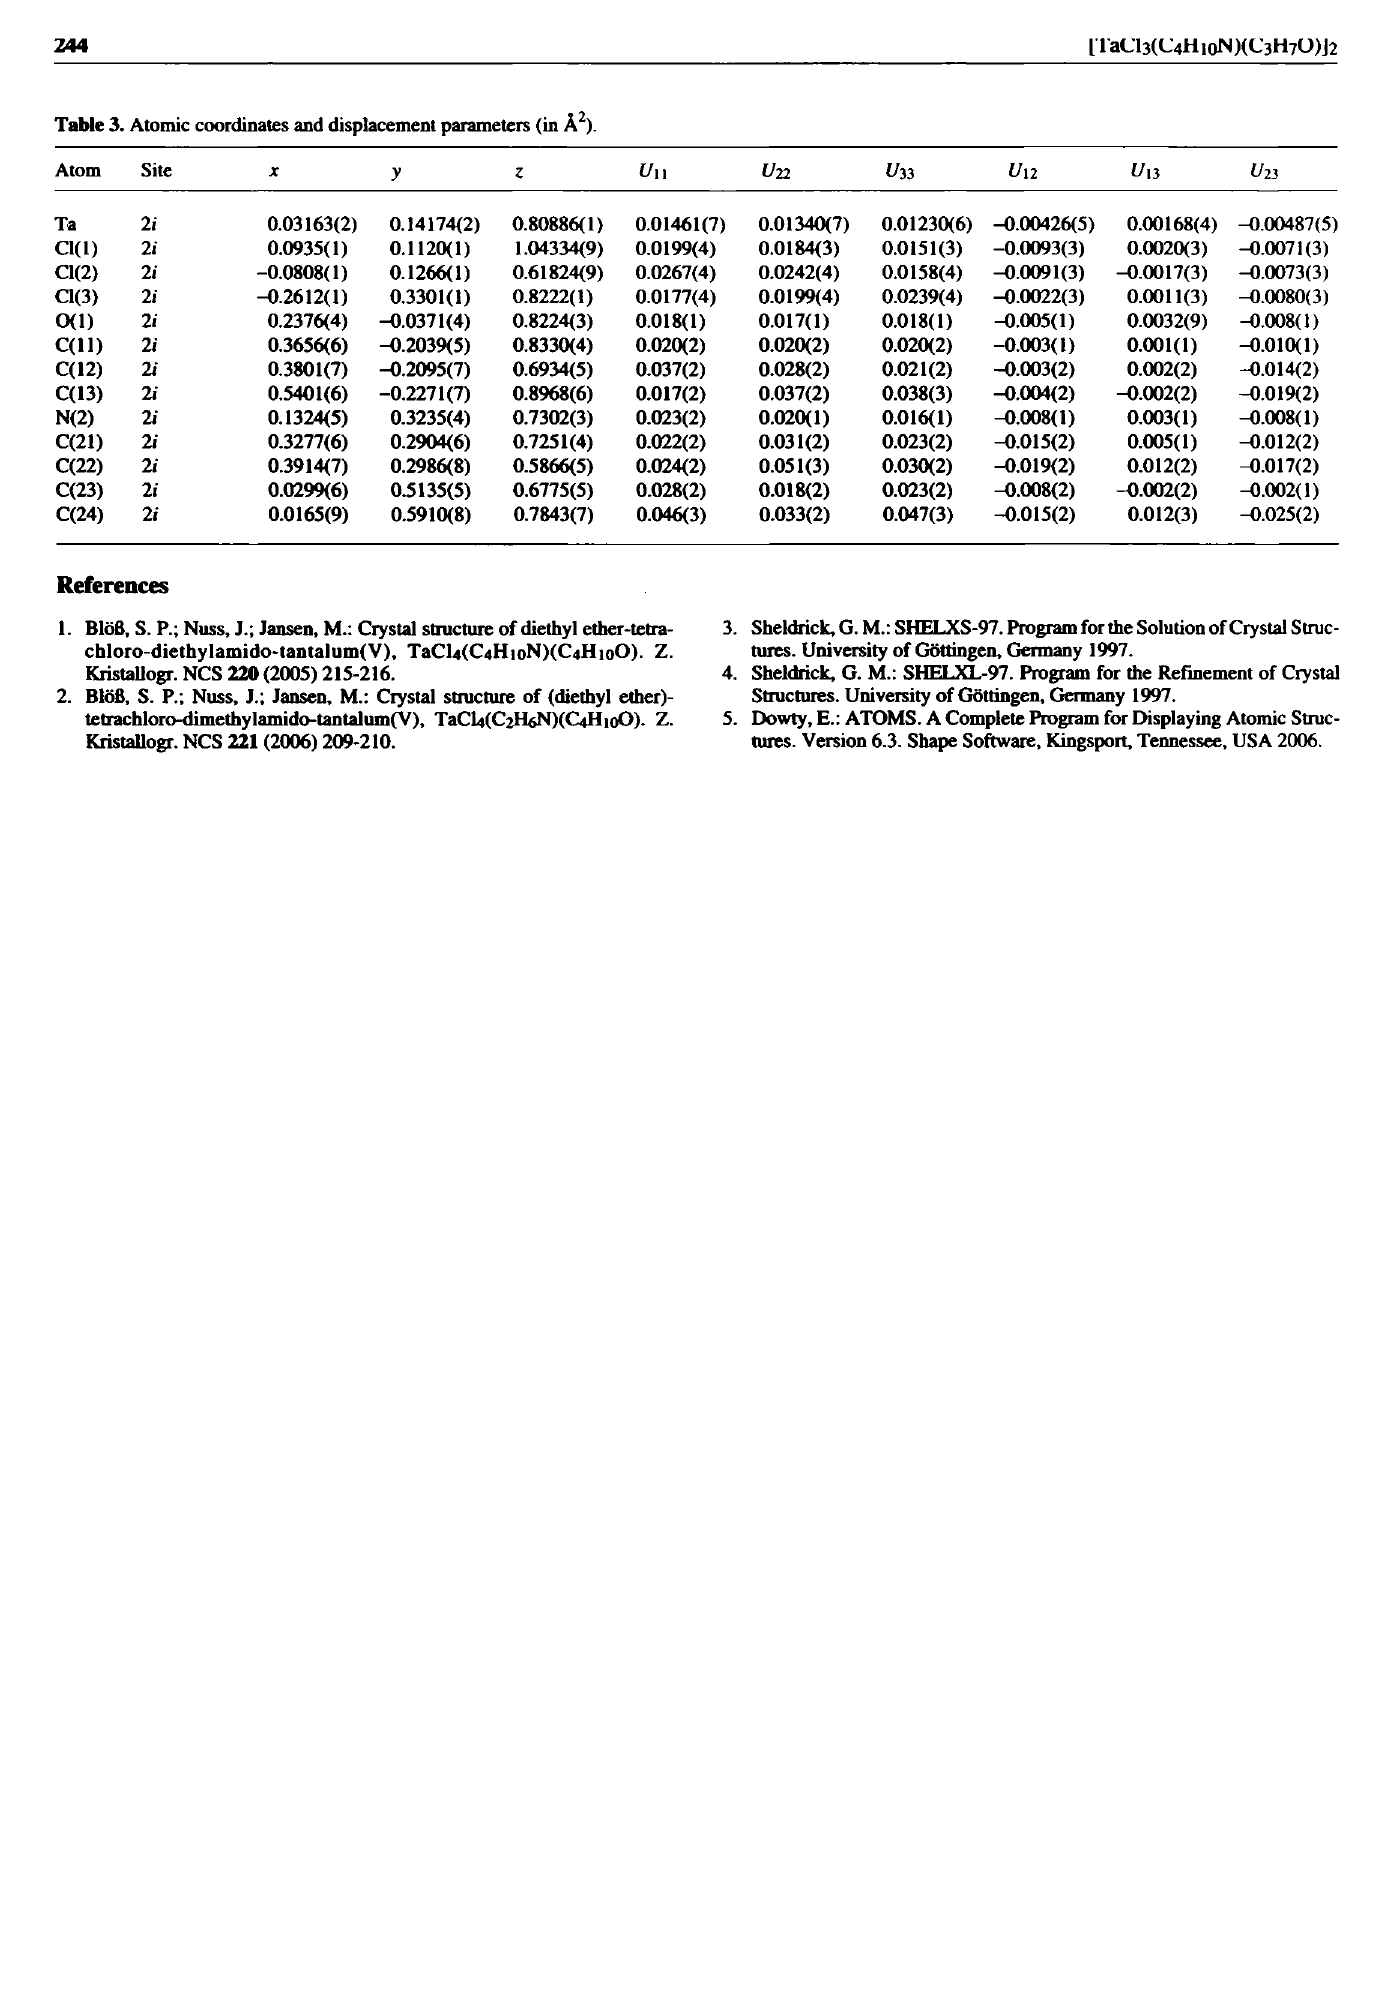
Table 3. Atomic coordinates and displacement parameters (in Â 2